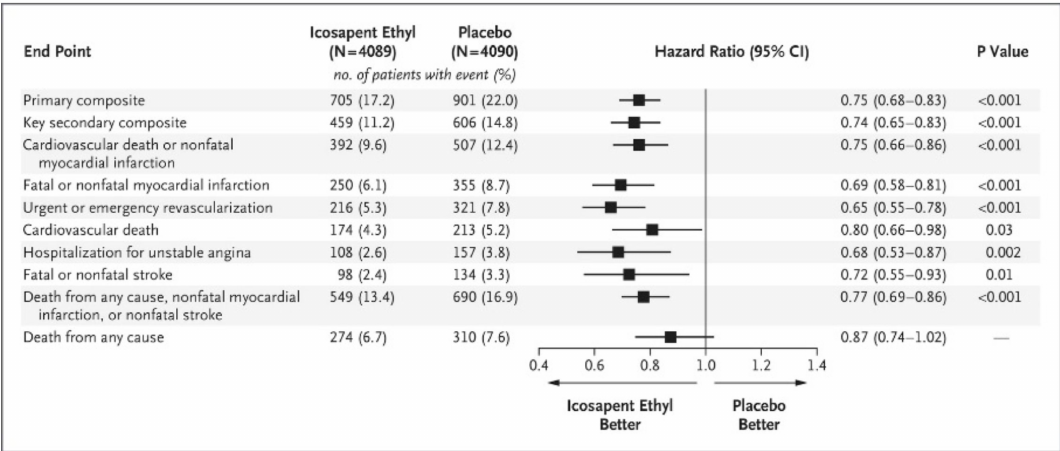
Figure 2. E ff ect of icosapent ethyl compared with placebo on di ff erent endpoints in REDUCE-IT